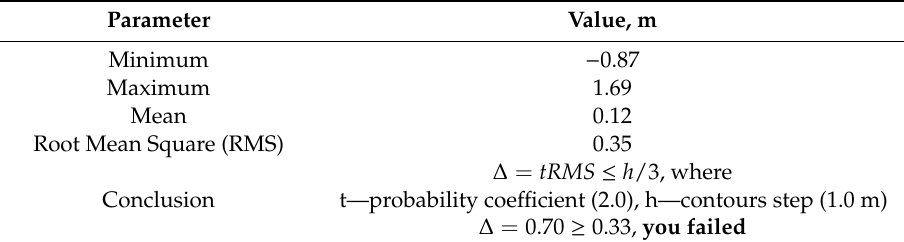
Table 1. Statistical characteristics.